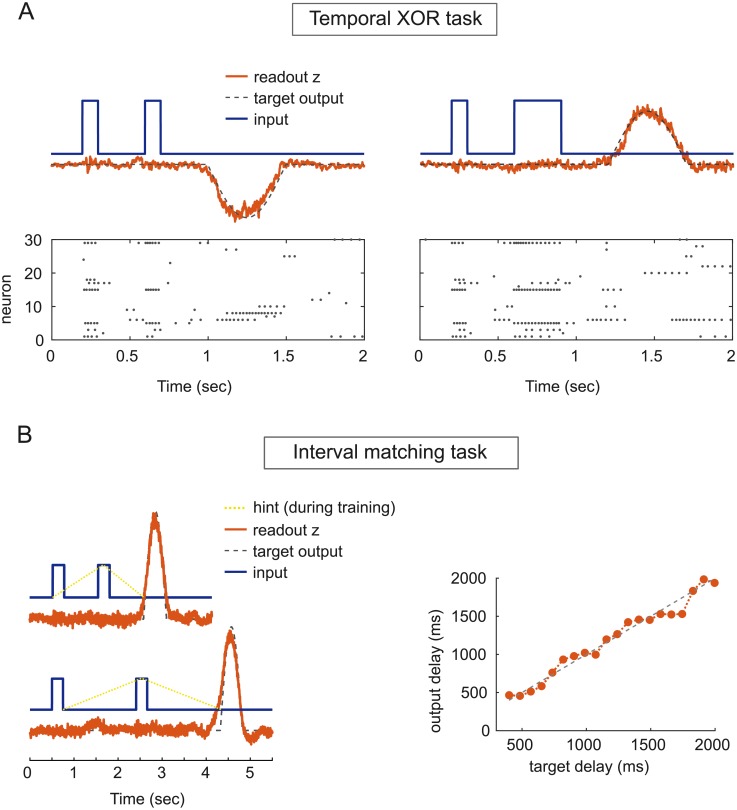
Input-output tasks.A: Example of output responses (red curves) of a balanced E/I spiking network trained on the temporal XOR task to two sets of input pulses (Blue curves) respectively coding for False-False (left) and False-True (right) Parameters: N = 1000, τs = 50 ms. B: Interval matching task. Left: sample output (red curves) vs desired output (dashed black curves) from a spiking E/I network trained on the Interval Matching Task to two pairs of input pulses. Right: output delay vs target delay ΔT to randomly interleaved test input pulses.